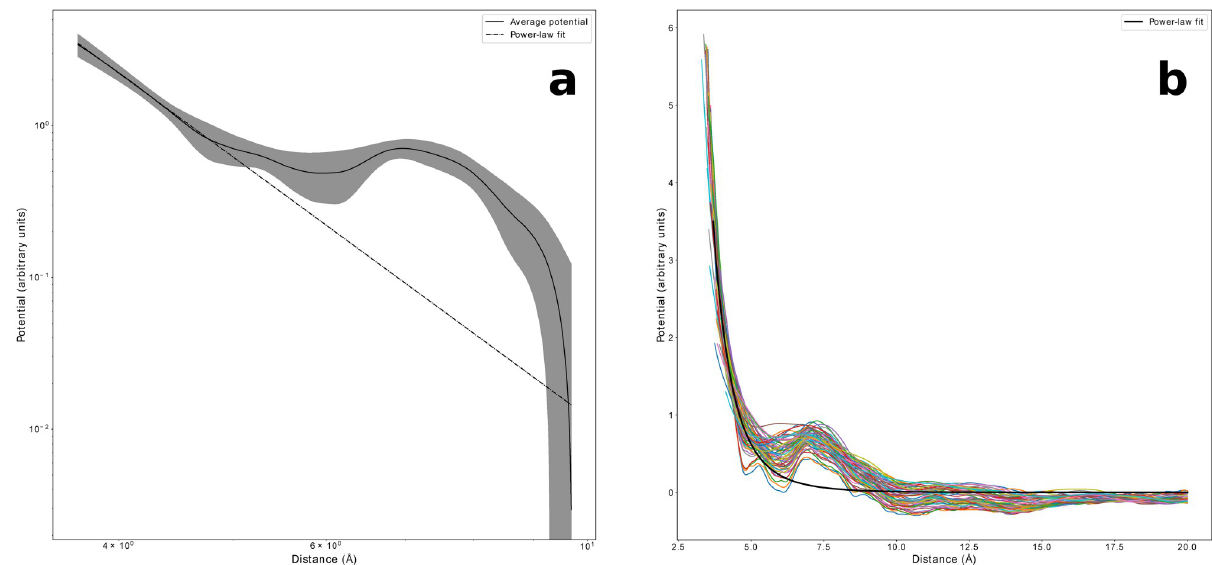
Fig 5. Short distance behavior of the empirical knowledge-based potential. Potential V ð R Þ for the CA case, obtained when averaging the statistical potentials (9) over all fragment lengths 30 � m � 90, shown together with the power-law fit at short distances. The exponent estimate is − 5.7 ± 0.3. ( a ) log-log scale; the standard deviation is also shown. ( b ) linear scale with data collapse of all V m ( R ) potentials for different values of sequence separation 30 � m � 90. Figure drawn with python package matplotlib, version 3.4.1. URL